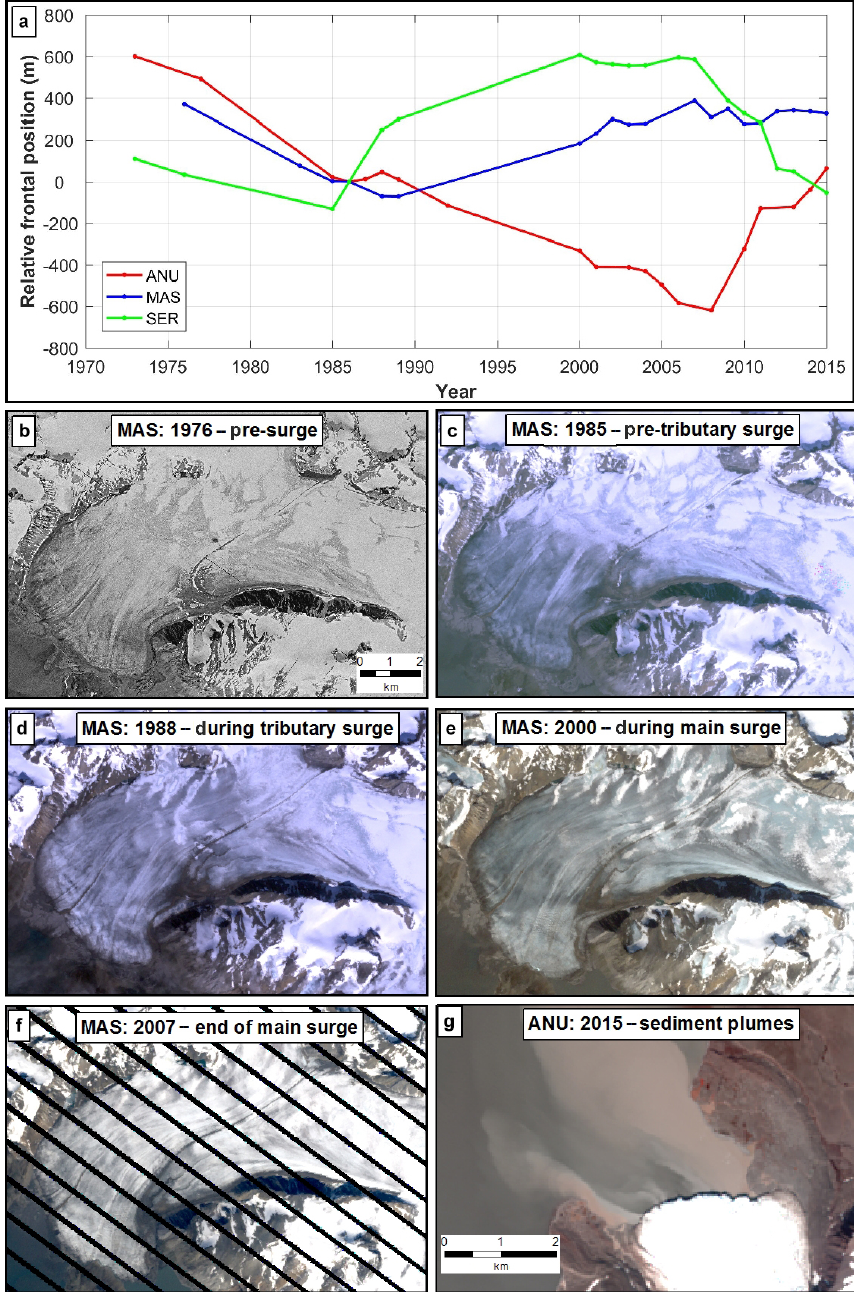
Figure 10. Glaciers identified as surging during the study period, based on the surge criteria compiled by Grant et al. (2009). (a) Glacier frontal position (relative to 1986) for glaciers identified as surge type: Anuchina (ANU), Mashigina (MAS), and Serp i Molot (SER). (b) Pre- surge imagery of MAS. Imagery source: Hexagon, 22 July 1976. (c) Tributary prior to the appearance of obvious surge-type features. Imagery source: Landsat 5, 26 July 1985. (d) MAS during the surge of its tributary. Imagery source: Landsat 5, 13 August 1988. (e) MAS during the surge of the main glacier trunk. Imagery source: Landsat 7, 13 August 2000. (f) MAS at the end of main glacier the surge, showing the maximum observed extent of the main terminus. Imagery source: Landsat 7, 8 July 2007. (g) Sediment plumes emerging from the margin of ANU during its recent surge. Imagery source: Landsat 8, 31 July